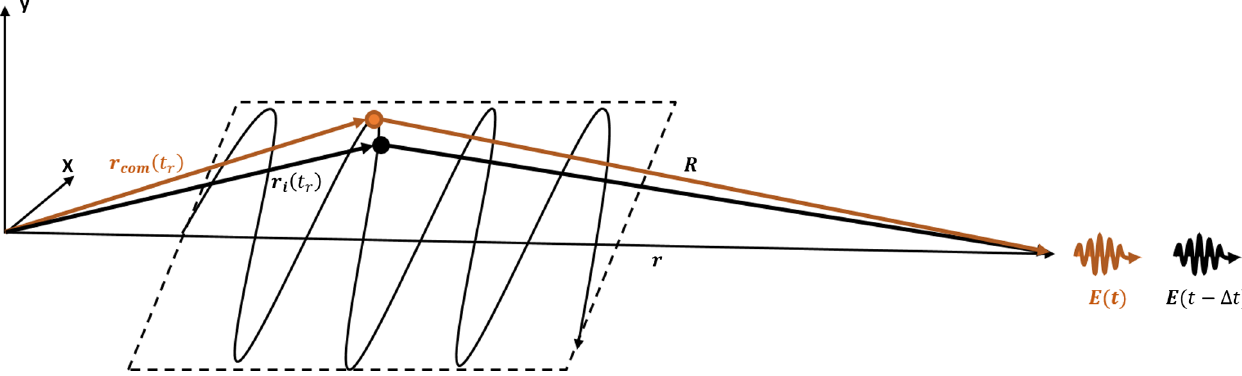
FIG. 6. Radiation emitted by electrons positioned at r com ð t r Þ and r i ð t r Þ reaches the observer situated at R at t − δ t and t respectively. The overall profile of the radiation is superposition of waves emitted by all electrons with respect to the center of mass with “ time-delay ” accounted for as a